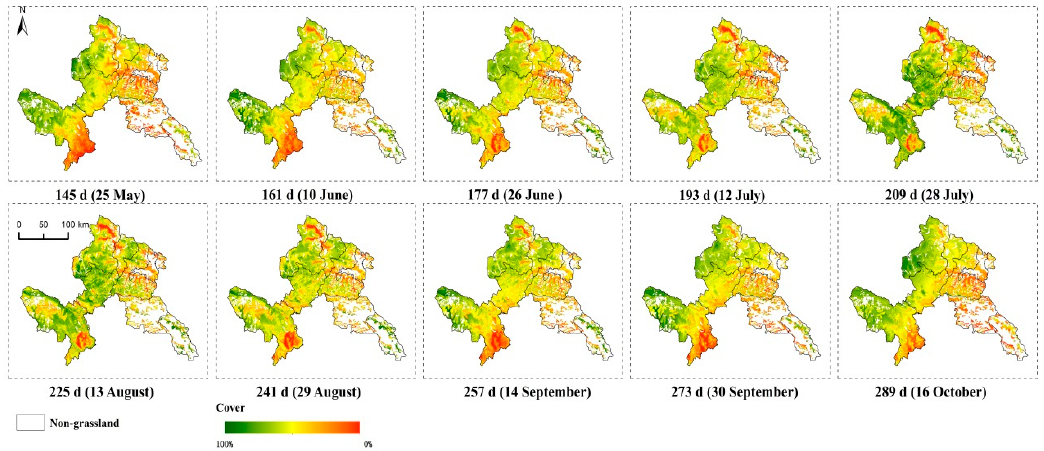
Figure 3. Spatial distribution of the average grassland cover for days 145–289 (per 16 days), on a pixel by pixel basis, in Gannan, from 2000 to 2016.